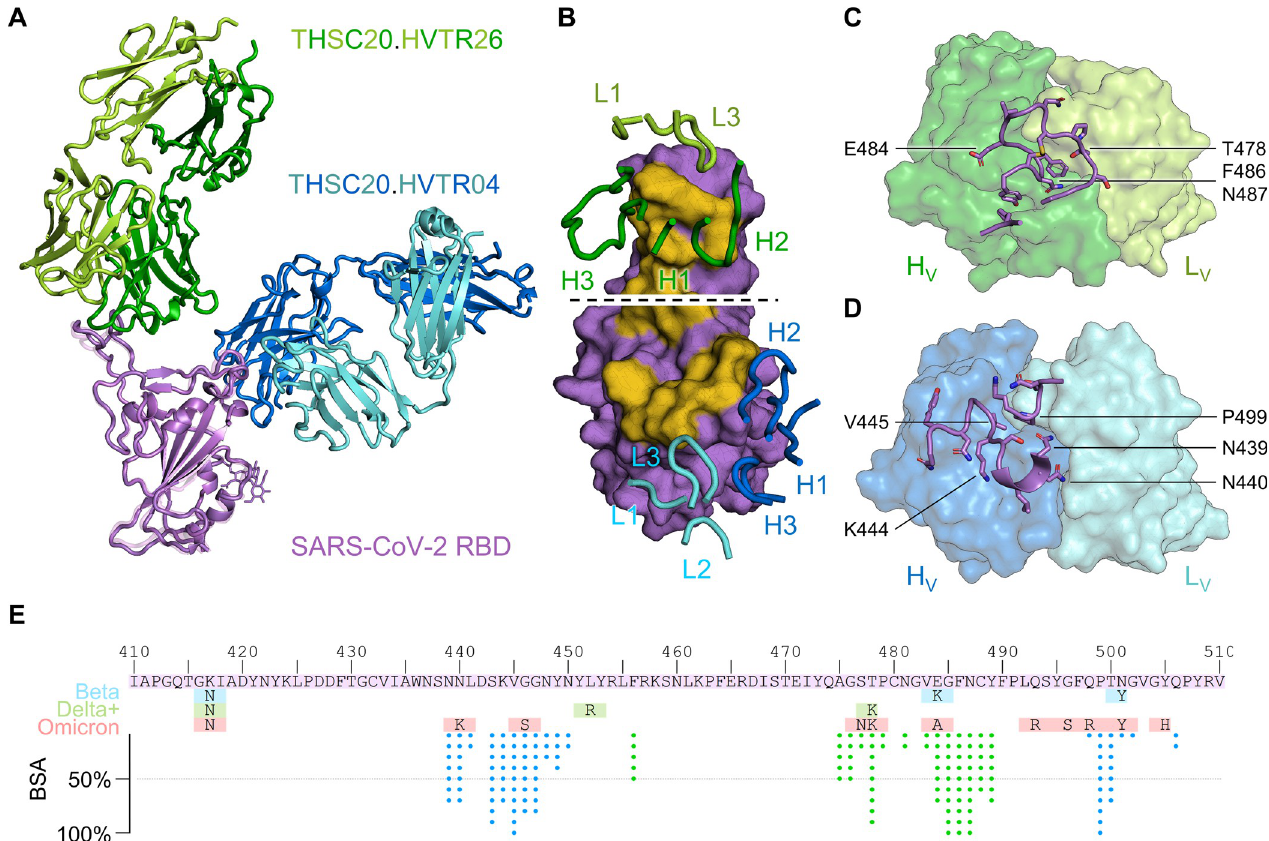
Fig 5. X-ray crystallography of THSC20.HVTR04 and THSC20.HVTR26 complexed with SARS-CoV-2 RBD. A. Schematic of THSC20.HVTR26 Fab (PDB 7Z0X, shown in dark and light green for heavy and light chains respectively) and THSC20.HVTR04 Fab (PBD 7Z0Y, shown in dark and light blue), bound to SARS-CoV-2 spike RBD (shown in purple/pink respectively). Structures were aligned by RBD. B. Surface view of SARS-CoV-2 RBD from PDB 7Z0X (top) or 7Z0Y (bottom), viewed from the angle of ACE2 approach, with the ACE2 binding site colored gold. Complementarity determining regions are shown in cartoon view, labelled, and colored as in A. C. Surface view of THSC20.HVTR26 Fab variable domains (colored as in A). RBD residues 475–489 and F456 are shown in purple cartoon and stick view. Key amino acids E484, T478, F486, and N487 are labelled. D. Surface view of THSC20.HVTR04 Fab variable domains (colored as in A). RBD residues 439–450 and 498–502 are shown in purple cartoon and stick view. Key amino acids V445, K444, P499, N439, and N440 are labelled. E. Primary sequence of SARS-CoV-2 RBD positions 410 to 510 (purple), and mutations associated with the Beta (cyan), Delta+ (lime), or Omicron (salmon) variants. The percentage of accessible surface for each amino acid that was bound by THSC20.HVTR04 or THSC20.HVTR26 was calculated (% buried surface area) and plotted using blue or green dots respectively, where each dot represents ~10% of the total solvent accessible surface